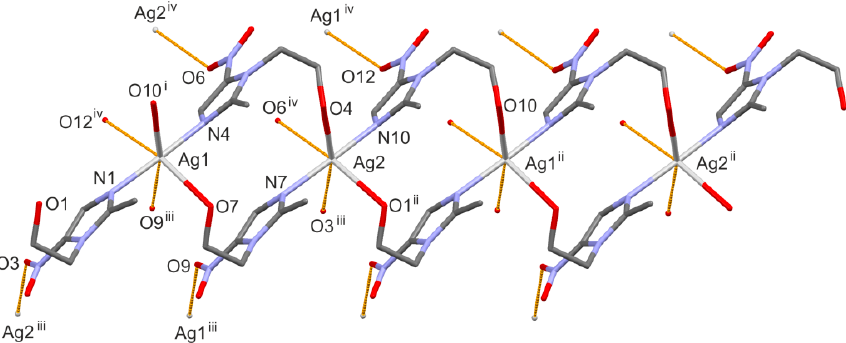
Figure 3. A scheme of interactions with silver(I) cations. The yellow dotted lines indicate weak Ag ∙∙∙ O contacts. Symmetry codes: i x − 1, y − 1, z; ii x + 1, y + 1, z; iii 1 − x, 1 − y, 2 − z; iv 2 − x, 1 − y, 2 − z.